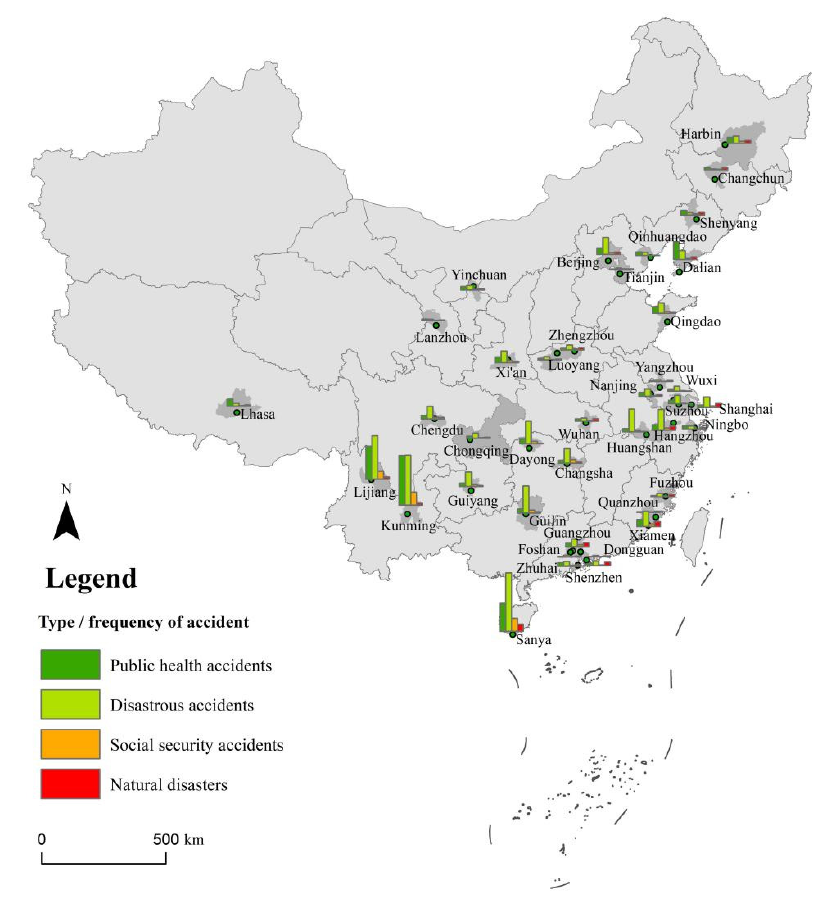
Figure 4. Frequency distribution of night tourism safety accidents in cities.